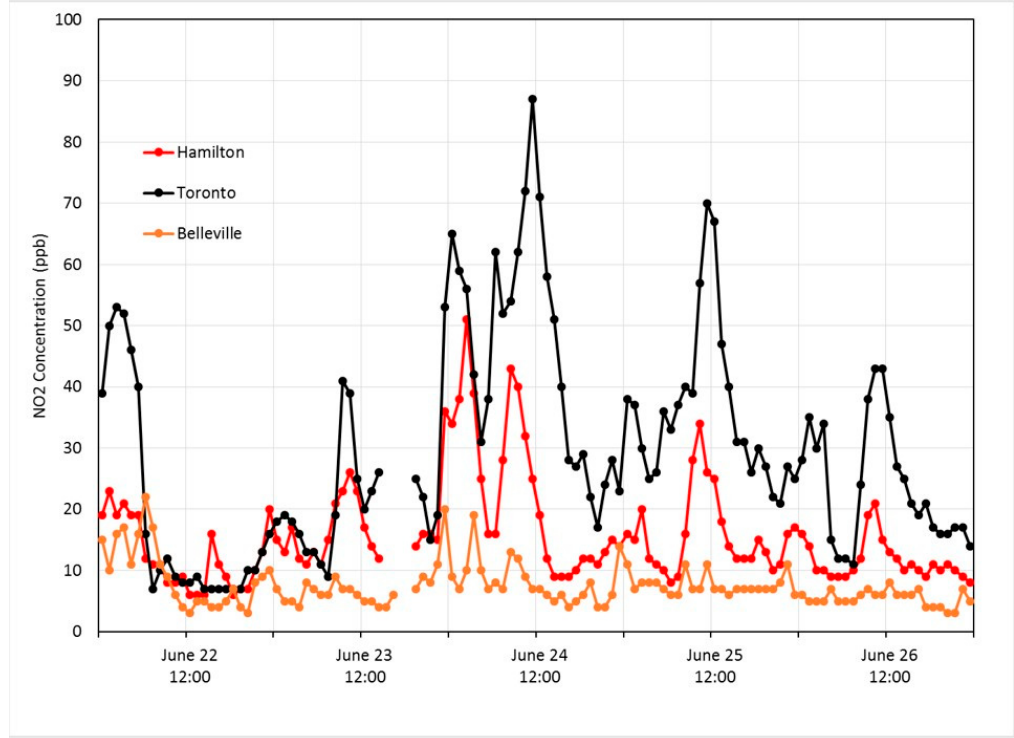
Figure 5. NO 2 hourly concentrations at Windsor and Toronto during 22–26 June 2003. Dates are shown at EDT (local time) 12:00.